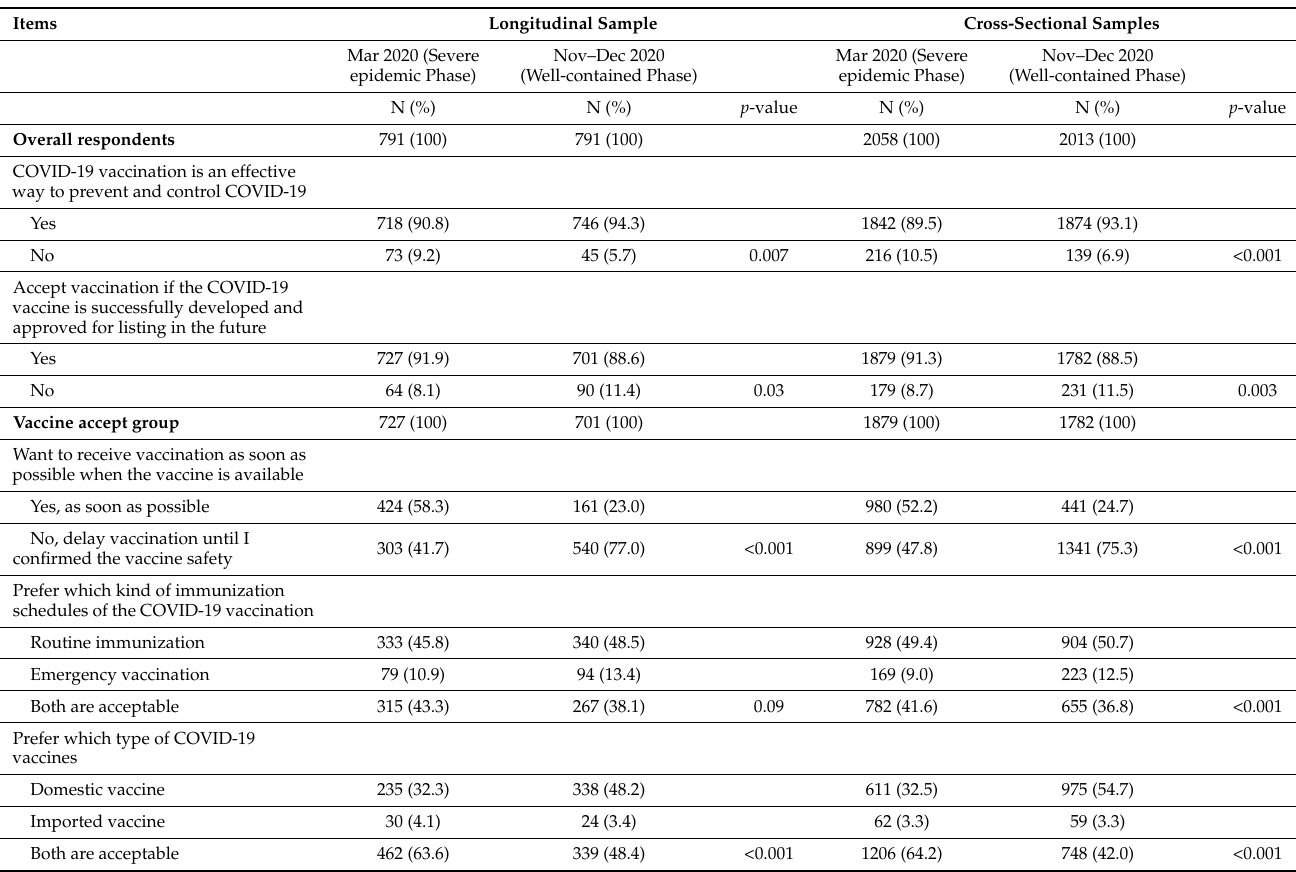
Table 1. Comparison of acceptance and preferences for COVID-19 vaccination between two consecutive surveys in the severe epidemic phase (Mar 2020) and the well-contained phase (Nov–Dec